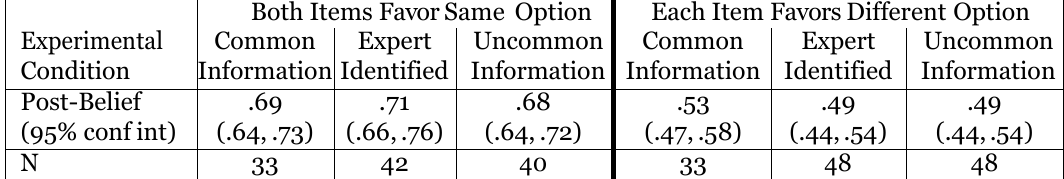
Table 2: Post-Deliberation Belief That Option Favored by Second Item is